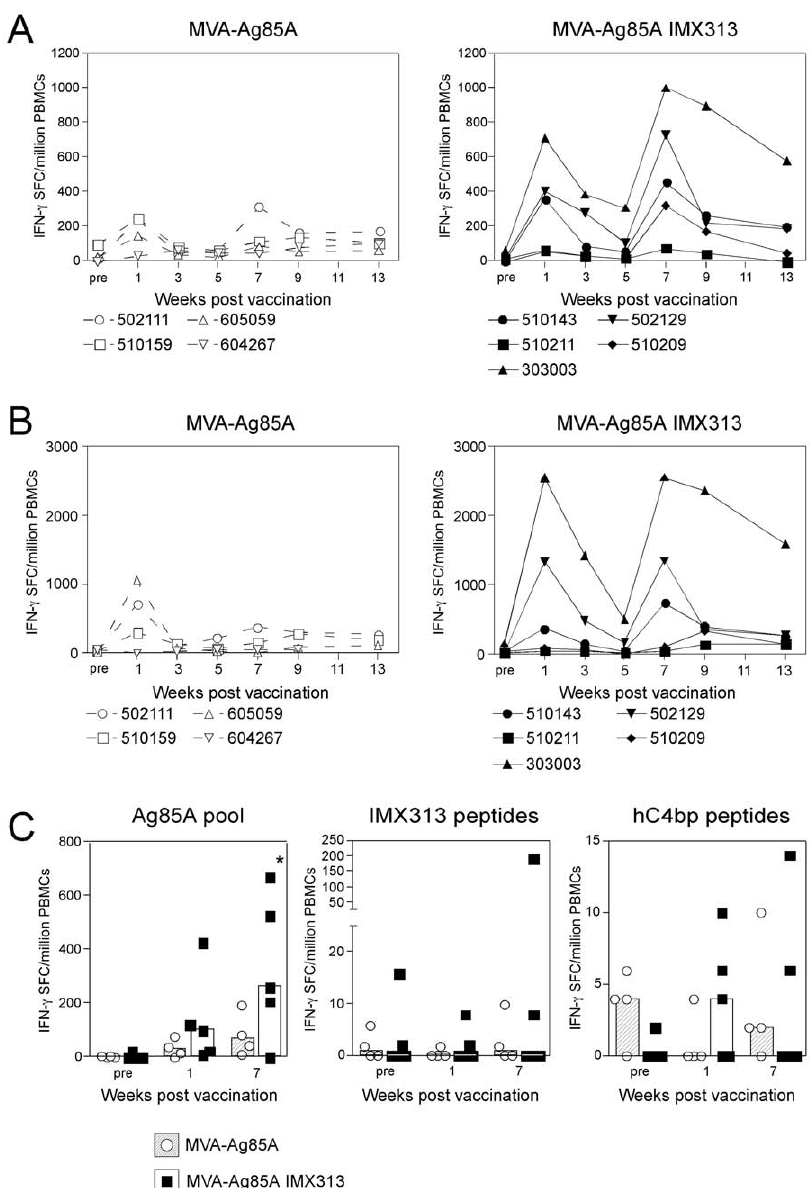
Figure 3. Macaque IFN- c ELISpot responses. Male rhesus macaques were immunized i.d. at weeks 0 and 6 with either 10 8 PFU MVA-Ag85A or MVA-Ag85A IMX313 and the response to antigen 85A measured in the blood by IFN- c ELISpot before vaccination (pre) and every 2 weeks from week 1 onwards. Graphs represent the response of each individual animal to a single pool containing all antigen 85A peptides ( A ) or the sum of 7 separate peptide pools ( B ). C ) Graphs represent the ELISpot responses of frozen PBMCs to a pool of antigen 85A peptides, a pool containing IMX313 peptides and a pool containing hC4bp peptides, pre-vaccination and at week 1 or week 7 post-vaccination. Bars represent the median group response with each animal displayed as a single point. Data was analyzed with a 2-way analysis of variance with a post-hoc Bonferroni test; the asterisks denote the level of statistical significance (*p , 0.05).